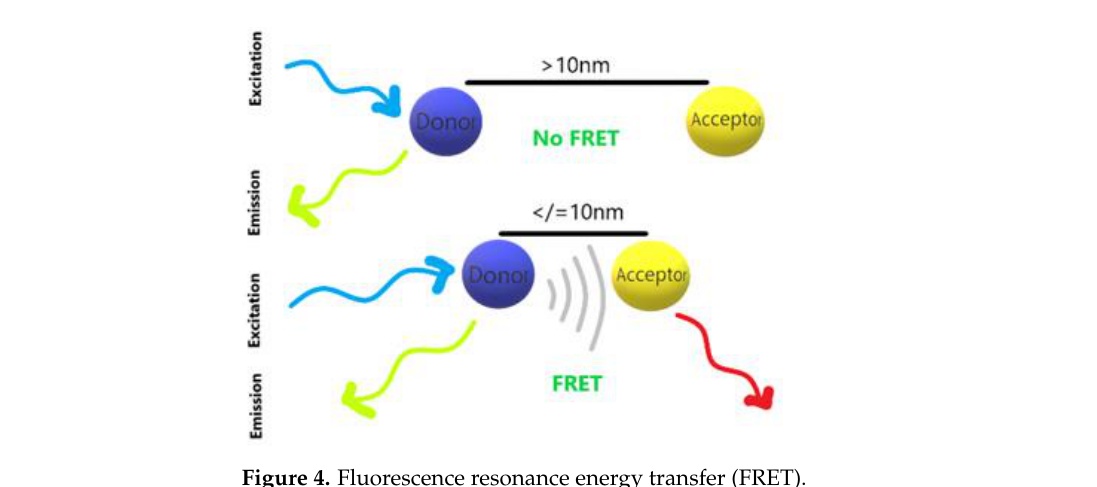
Figure 4. Fluorescence resonance energy transfer (FRET). Table 1. Comparison table of fluorescent